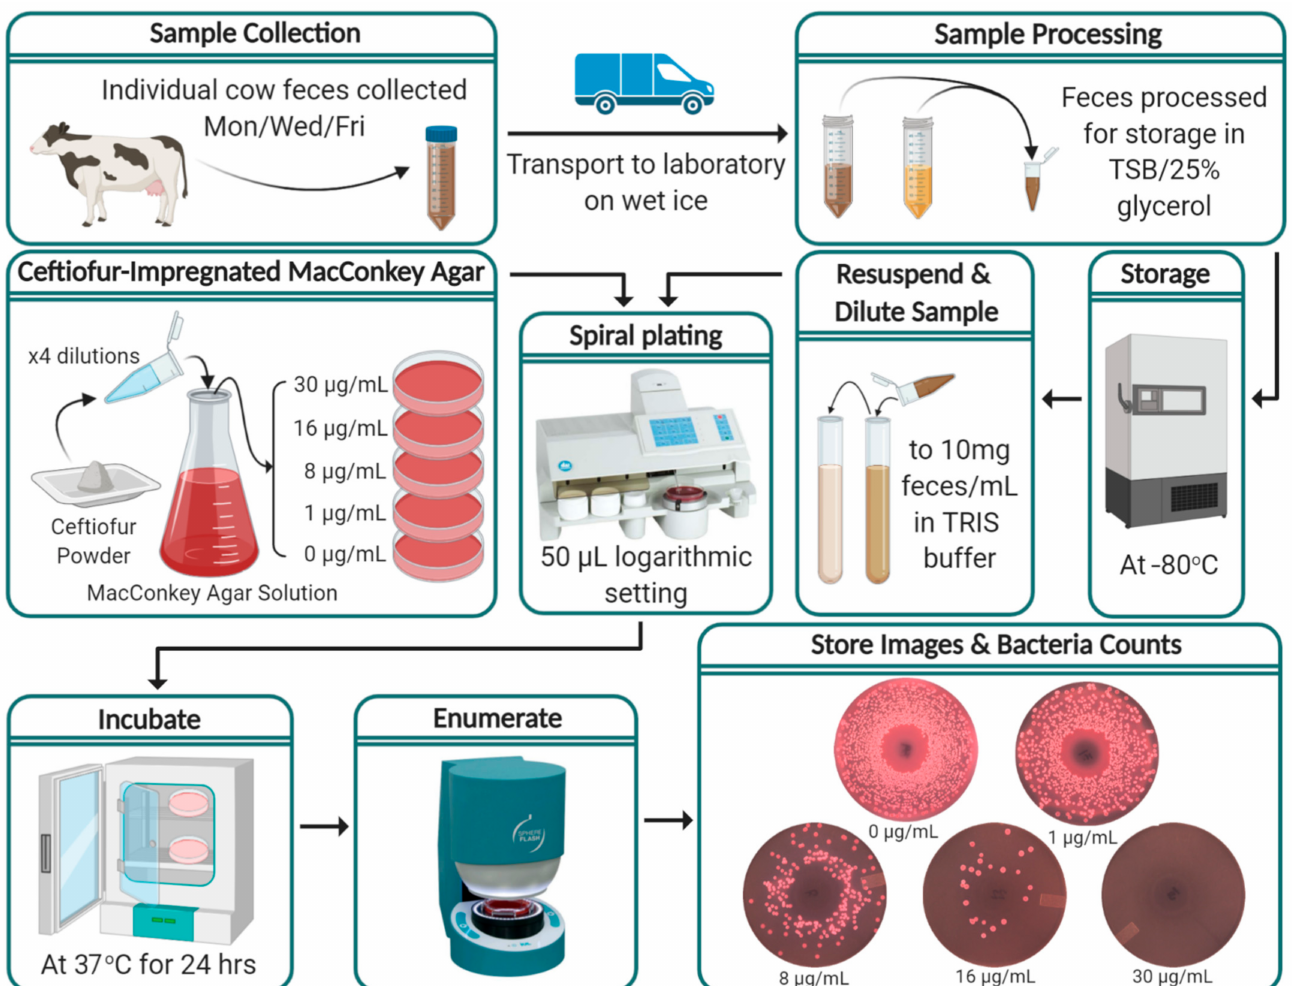
Figure 1. Flow diagram of study protocol from on-farm fecal sample collection through to the enumeration of Enterobacteri- aceae and storage of results. (Figure created with BioRender.com; Spiral plating and enumerate steps’ images are credited to Microbiology International, Frederick, MD and IULmicro, Barcelona,